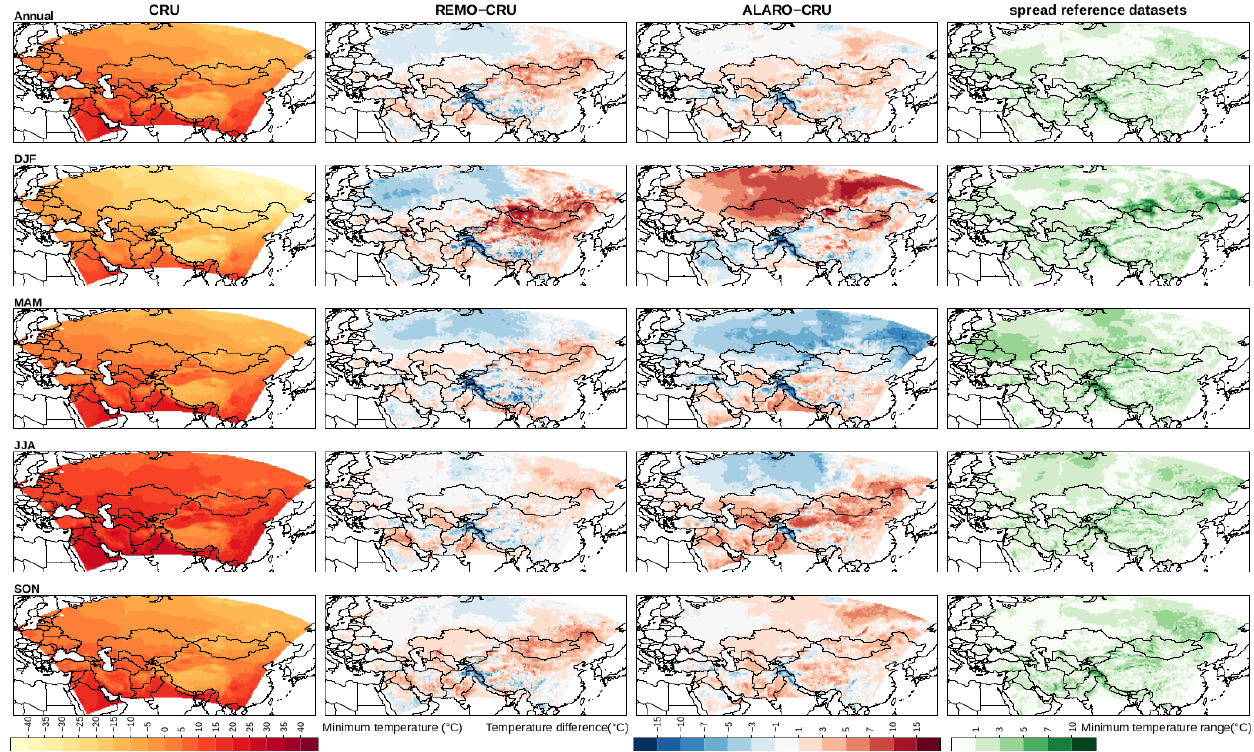
Figure 6. Left column: minimum air temperature ( ◦ C) at 2m height over the CAS-CORDEX domain based on the observational CRU dataset for the 1980–2017 period on an annual level and for winter (DJF), spring (MAM), summer (JJA), and autumn (SON). Middle columns: difference in minimum temperature between the models and CRU. Right column: the range in minimum temperature ( ◦ C) between the different reference datasets (CRU and